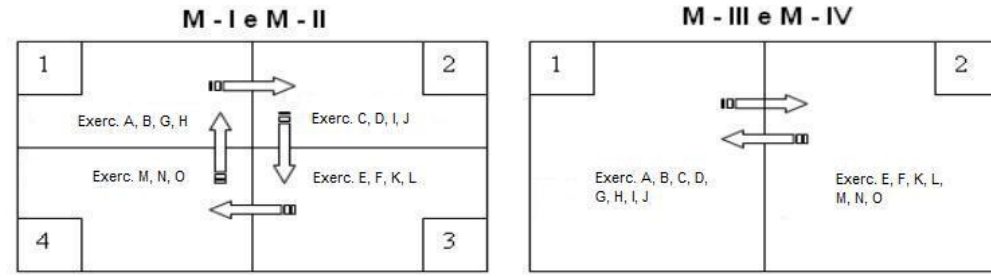
Figura 4. Desenho da piscina dividida em estações. O quadro à esquerda representa as quatro estações dos mesociclos M – I e M – II e quadro à direita representa as duas estações dos mesociclos M – III e M – IV, assim como a ordem de troca de estação e os exercícios realizados em cada estação. Para análise dos dados coletados, utilizou-se estatística descritiva (média  desvio-padrão). Os dados